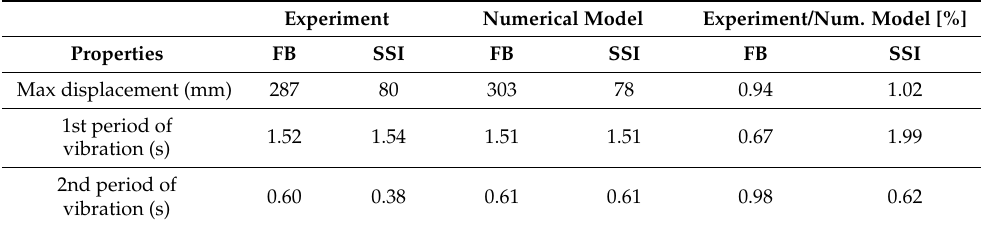
Table 5. Comparison between the scaled experimental results and numerical